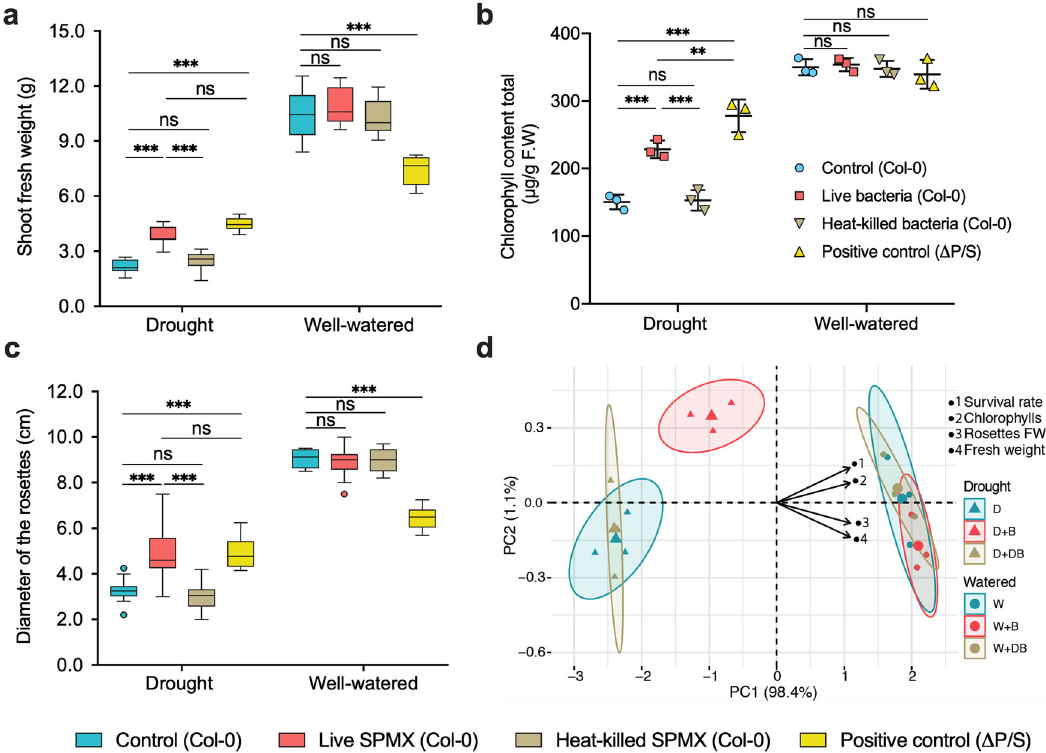
Fig. 2 The effect of inoculation with either living or heat-killed SPMX on plant growth. The physiological differences were shown in a shoot fresh weight (g) ( n = 9, nine replicates from three independent experiments); b total chlorophyll content ( μ g/g) ( n = 3, three independent experiments) and c rosette diameter (cm) under fresh weight (FW) after 21 dpi of drought or watered treatment ( n = 10 replicates from three independent experiments). d Biplot display of PCA of the parameters analyzed in A. thaliana Col-0 pot-grown plants. Treatments: W (well-watered condition) and D (drought condition), inoculated with SPMX (W + B) and (D + B), and with dead SPMX (W + DB) and (D + DB), respectively; variables: survival rate (%), rosette diameter FW (cm), fresh weight (g) and chlorophyll content ( μ g/g FW). Error bars represent mean ± standard deviation in a and b . Asterisks above histograms indicate whether two group percentage (different treatment vs. control) under drought are statistically signi fi cantly different as assessed by one-way ANOVA followed by a Tukey HSD test: ** P < 0.01, *** P < 0.001. (ns = no statistical